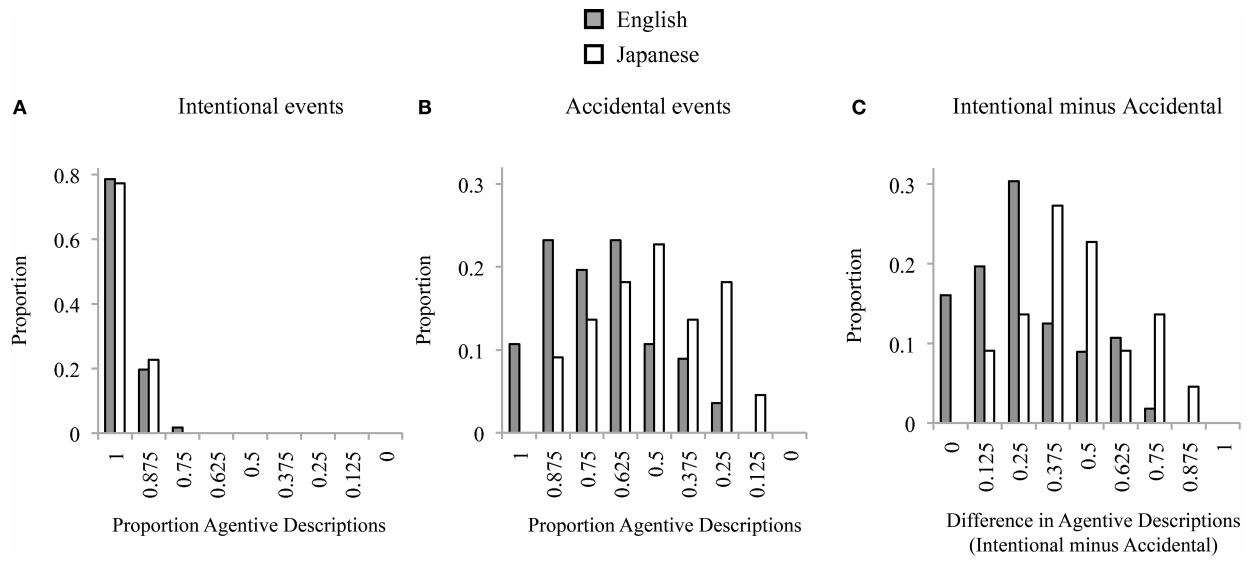
FIgure 1 | Distributions of causal event descriptions in english and Japanese. (A) Intentional, (B) accidental, (C) difference (Intentional minus Accidental). Histograms (with proportion of the sample on the y -axis) of the proportion of agentive language use in each language community are